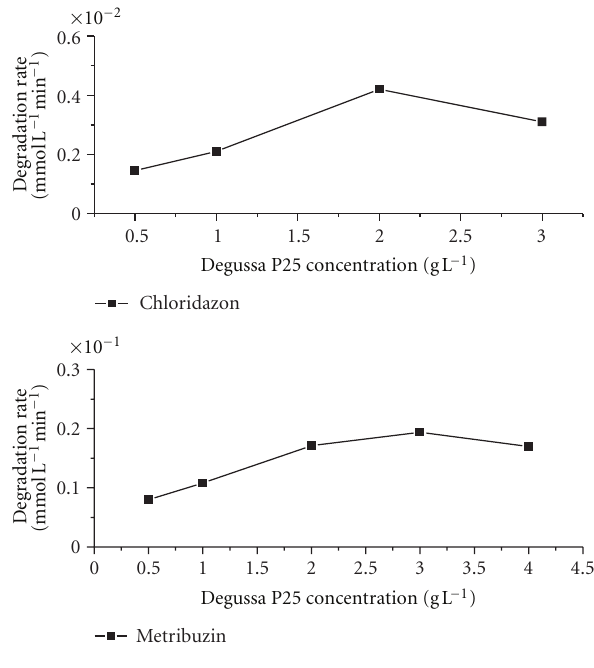
Figure 3: Influence of Degussa P25 concentration on the degradation rate of CHL and MET. Experimental conditions : CHL (0.18 mM), MET (0.30mM), TiO 2 Degussa P25 (0.5, 1, 2, and 3 and 4gL − 1 ), V = 125 mL, irradiation time: 60 min (CHL), 28min (MET).